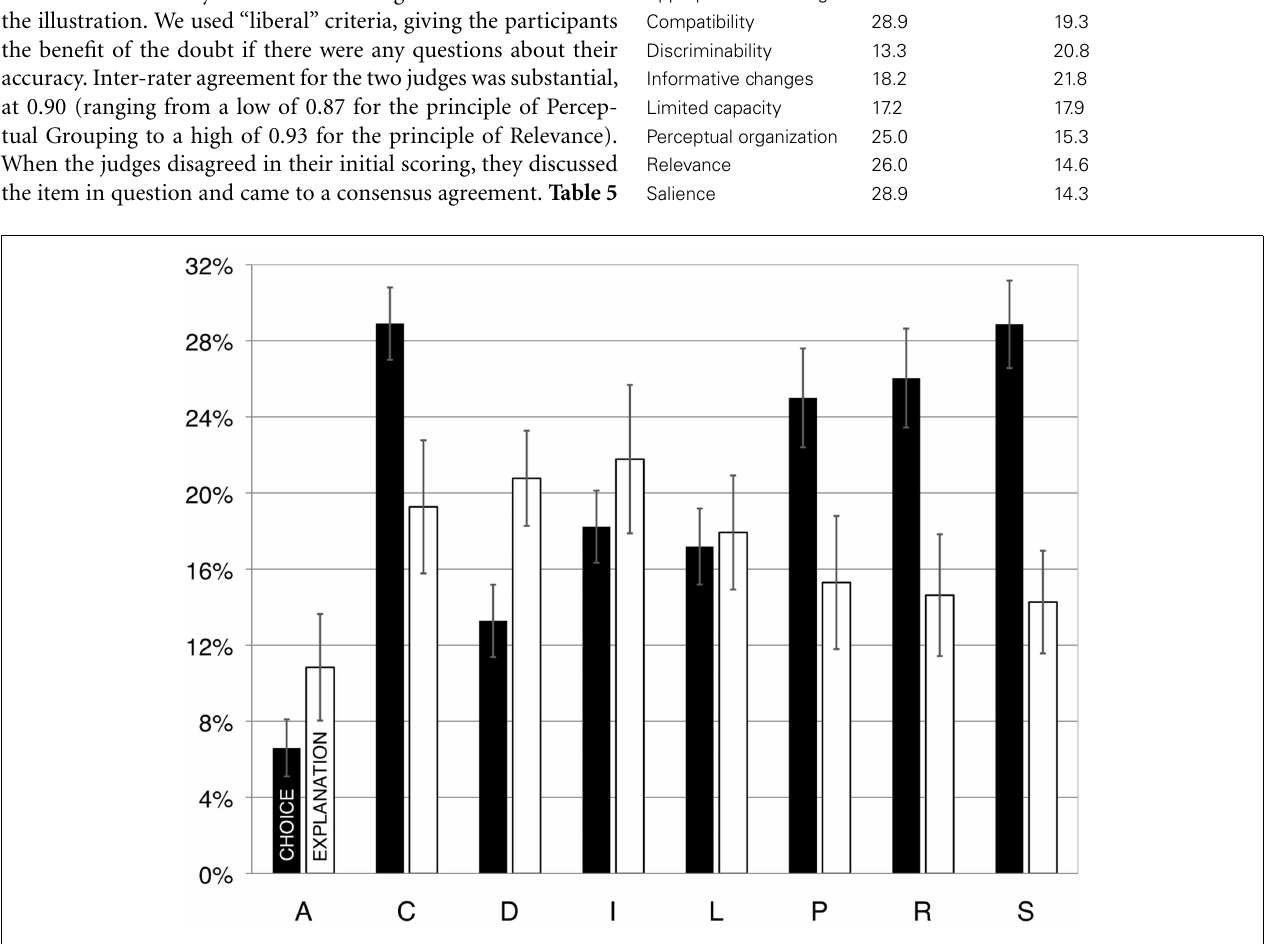
FIGURE 3 |The percentage of trials on which participants made errors in choosing the correct slide (dark bars), and explaining their choice (light bars) given that they chose the correct slide, in Study 3. A, appropriate